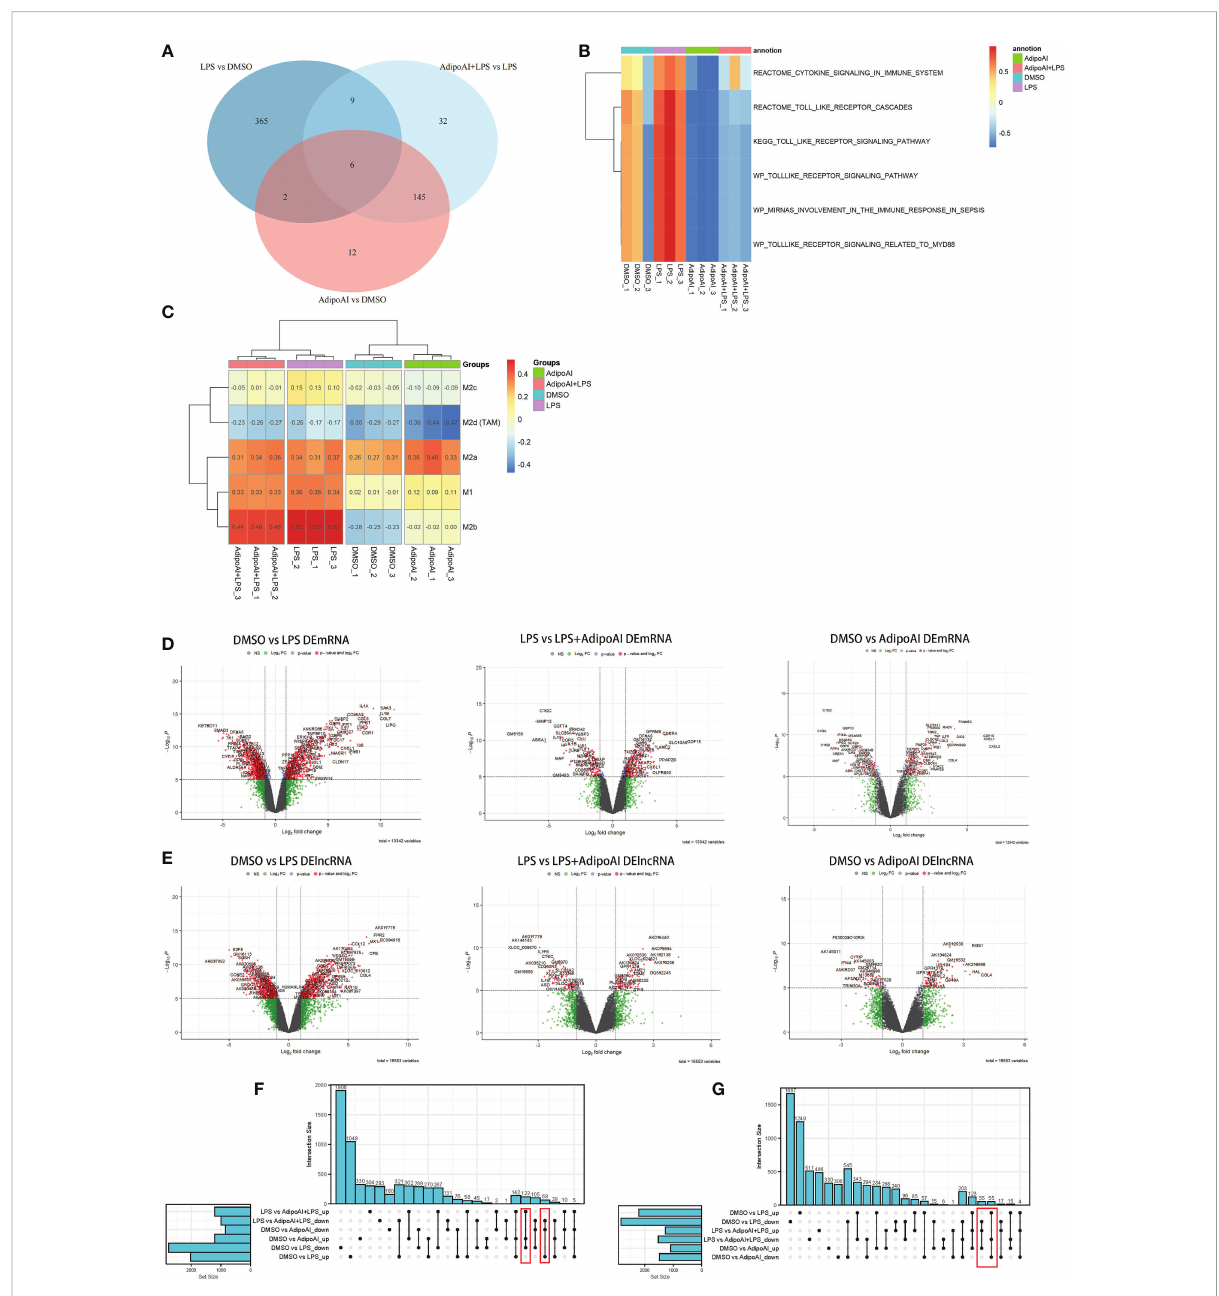
FIGURE 2 GSVA, macrophage phenotype ssGSEA and differential analysis. (A) Venn plot of pathways between three groups: DMSO vs. LPS, DMSO vs. AdipoAI and LPS vs. AdipoAI+LPS in GSVA. (B) Heatmap of GSVA scores in 12 samples. (C) Heatmap of macrophage phenotype ssGSEA scores in 12 samples. (D) Volcano plot for the mRNA differential analysis results. (E) Volcano plot for the lncRNA differential analysis results. (F, G) UpSet plots for the differentially expressed genes of (F) DEmRNAs or (G)